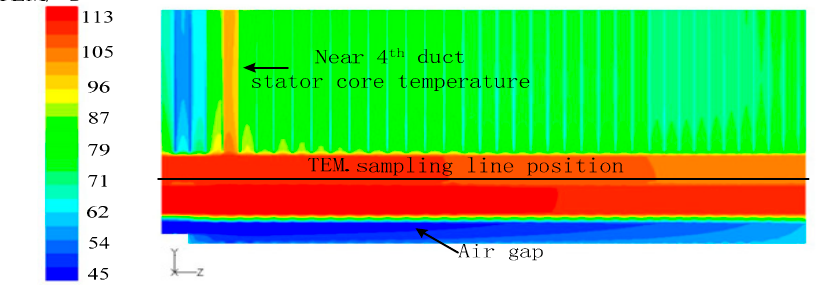
Figure 11. Temperature field of stator at air gap inlet velocity 56 m / s.